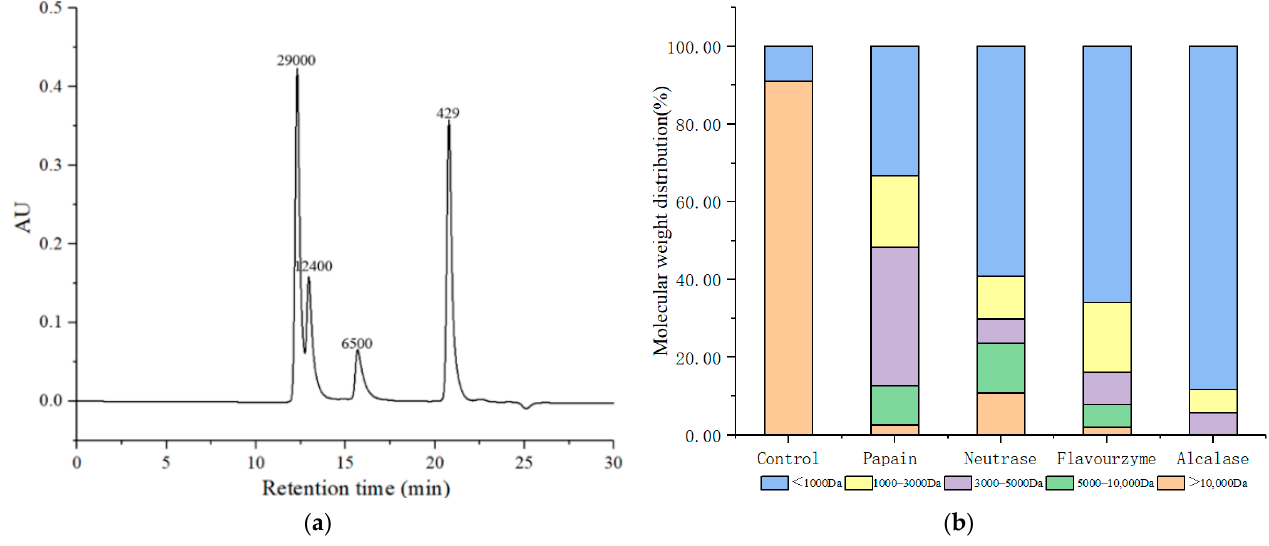
Figure 1. Molecular mass distribution of standards ( a ), and molecular mass distribution of LMPH obtained by papain, neutrase, flavourzyme, and alcalase ( b ).